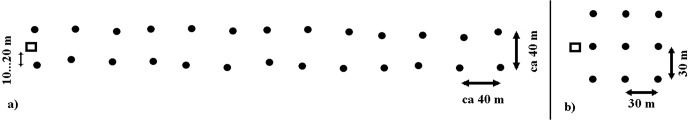
The first experimental design (a) and the adjusted design of the second experiment (b).Rectangles denote the location of the supplementary feeding site and dots correspond to nests in the vicinity of the site.